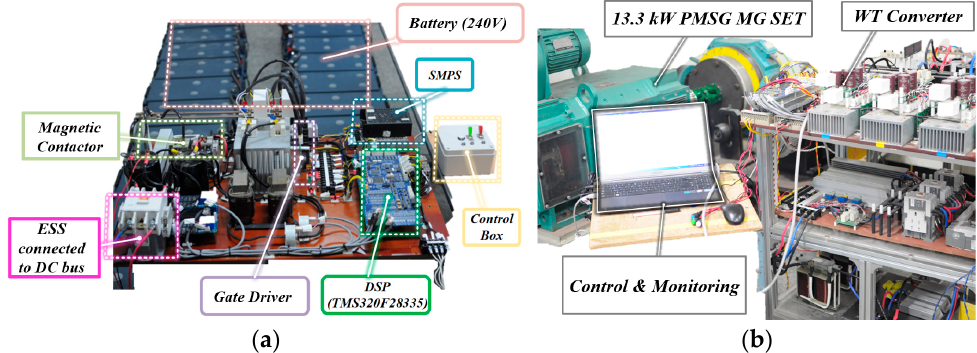
Figure 9. Experiment configuration of distributed energy resources ( a ) energy storage system, ( b ) wind turbine system.